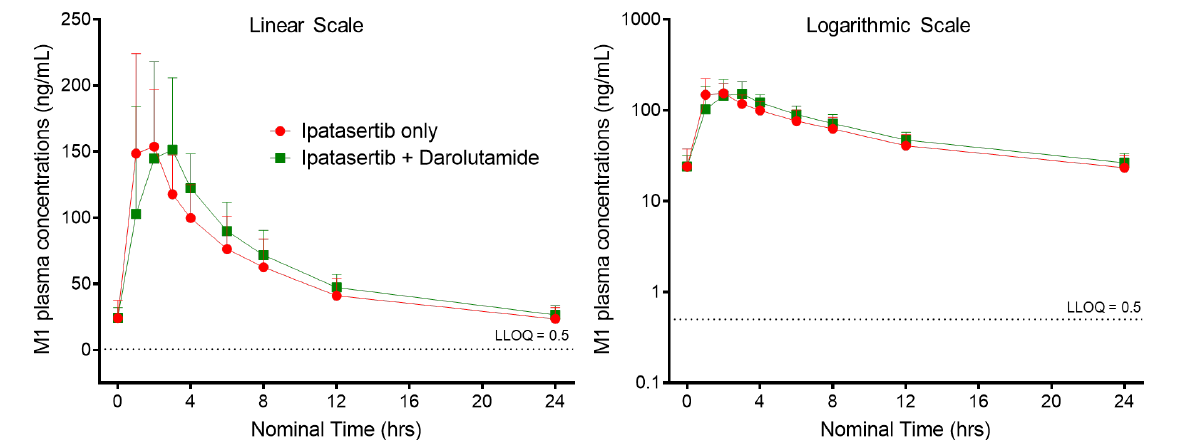
Figure 3. Arithmetic Mean ± SD concentration–time profiles of M1 (G-037720) presented as both linear and logarithmic scales following multiple-dose oral administration of ipatasertib 400 mg QD alone and in combination with darolutamide 600 mg